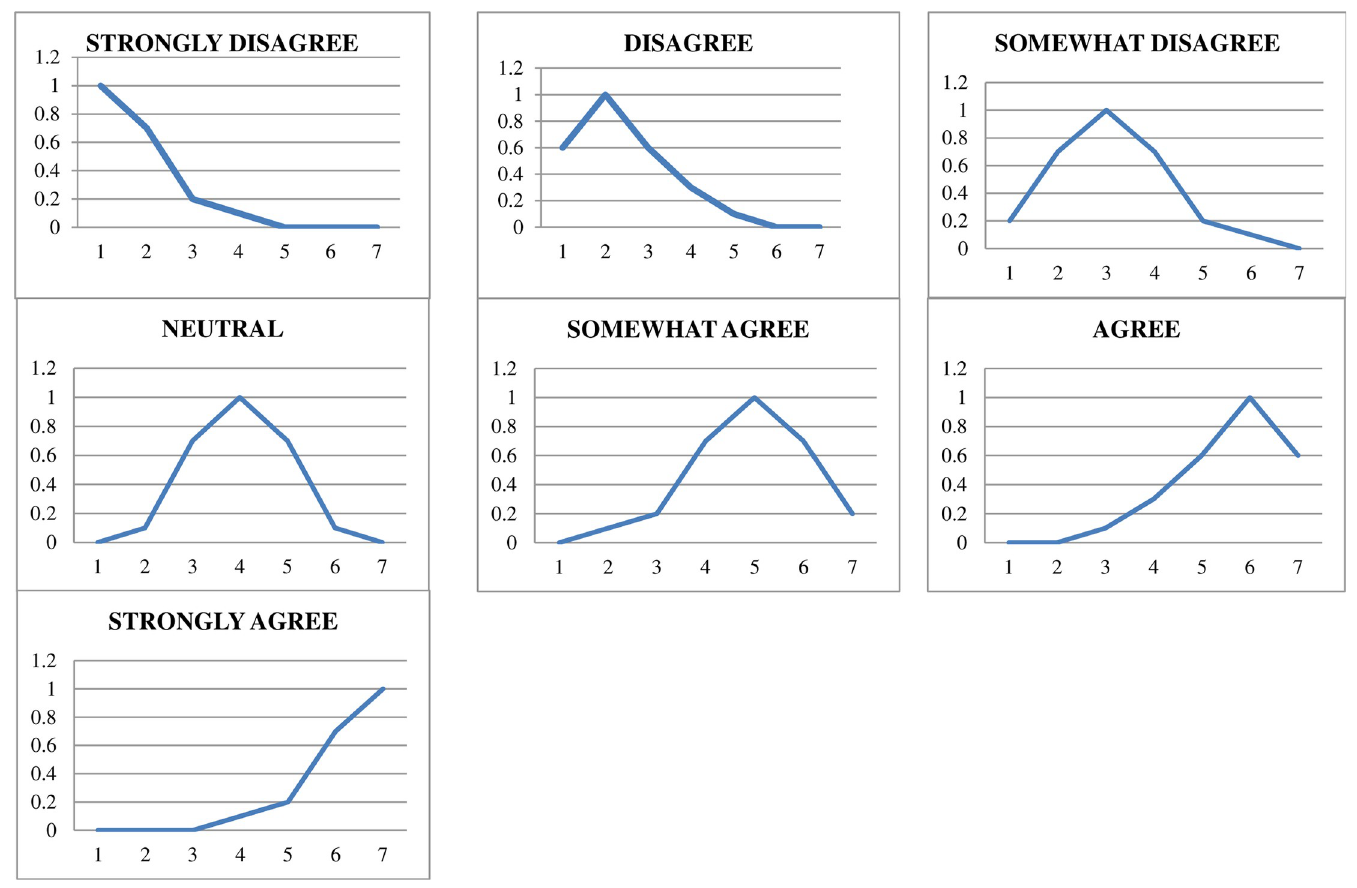
Fig 1. Graph of the fuzzy linguistic